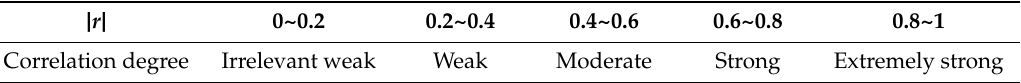
Table 2. Correlation degree between process